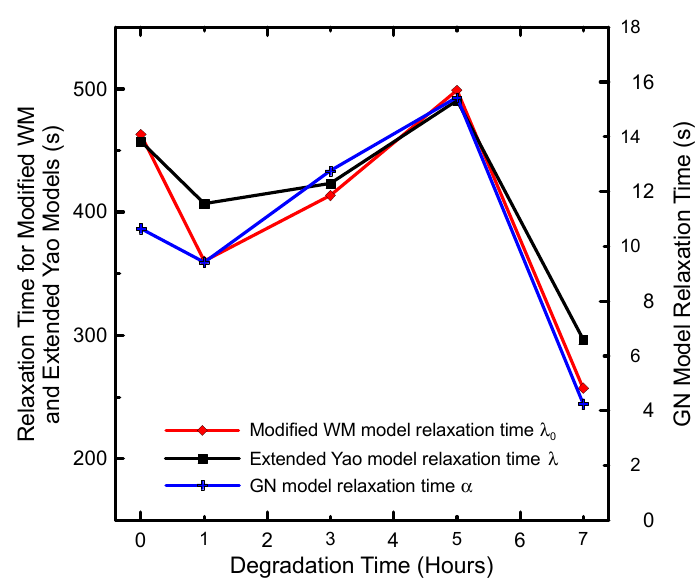
Figure 10. Model relaxation times for branched PP at 180 °C for different degradation times (raw data are provided in Tables 2, 3 and 5).